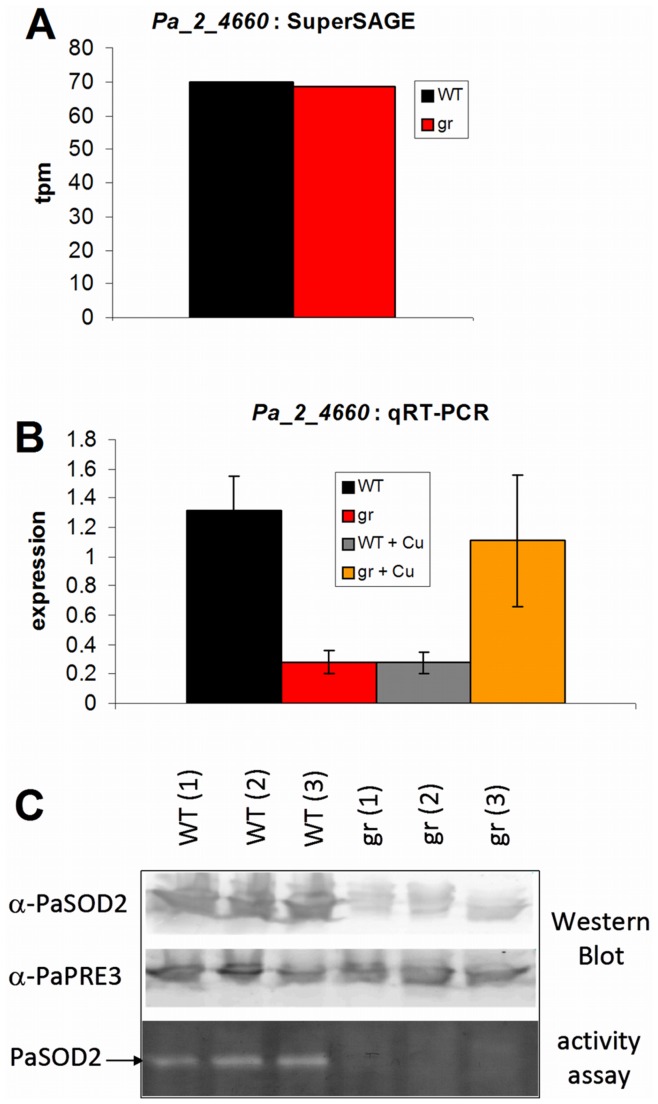
Transcript (A, B) and protein analysis (C) of Pa_2_4660 (PaSod2).The results of the SuperSAGE analysis (A) are shown as tags per million (tpm) for wild type (WT) and grisea (gr). The results of the qRT-PCR (B) are relative expression levels of the gene of the wild type (WT, n = 5) and of grisea (gr, n = 6) grown in standard medium, and wild type (WT+Cu, n = 3) and grisea (gr+Cu, n = 3) grown on copper supplemented medium, normalized to the expression level of gene coding for mitochondrial PORIN. The error bars represent the standard deviation. For Western Blot (α-PaSOD2) and in-gel SOD activity assay (C) 100 µg of total protein extracts of three independent wild type (WT) and grisea (gr) isolates were used. As loading control the α-PaPRE3 antibody was used.